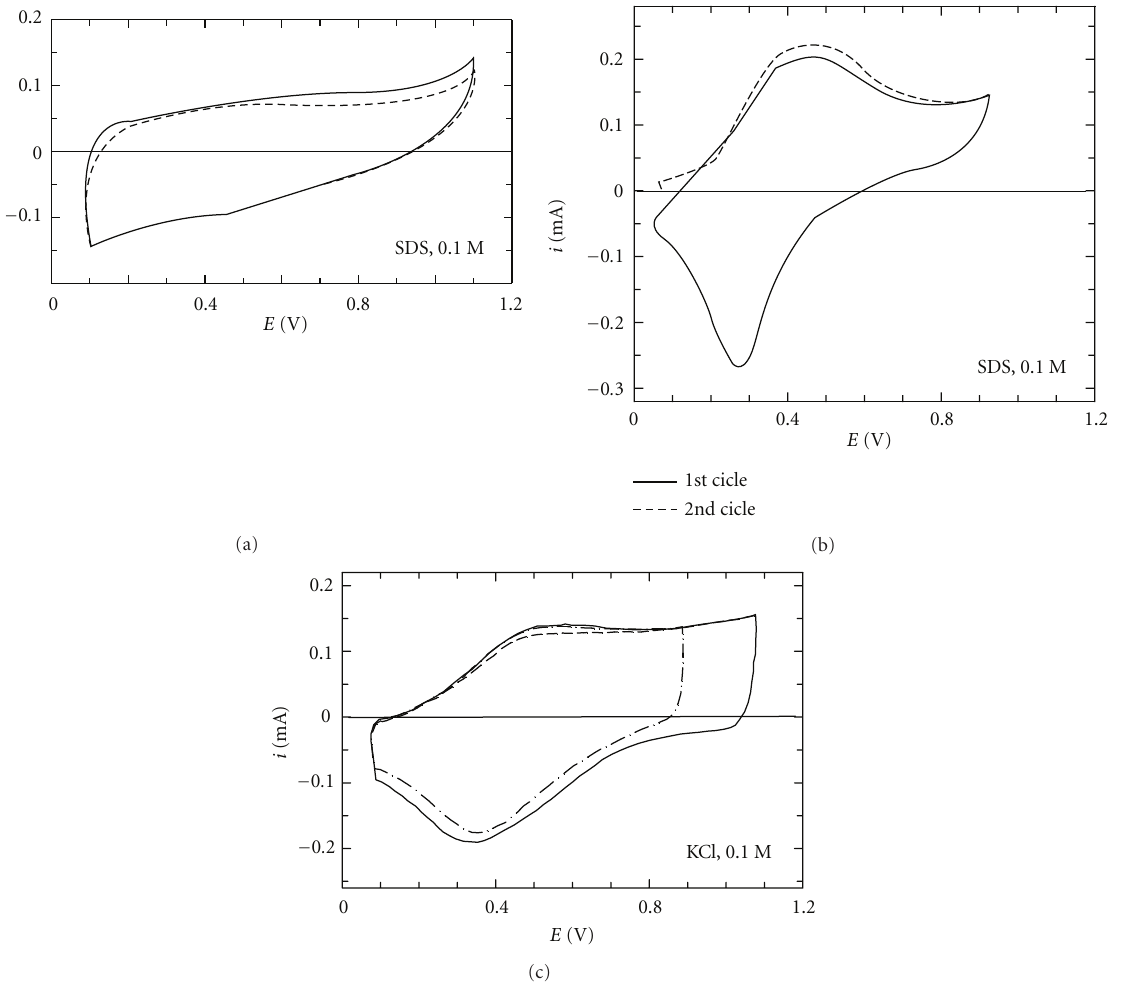
Figure 2: Current/potential voltammograms obtained scanning at 100 mV/s between Ec = 0.04 V and either Ea = 0.9V or Ea = 1.1 V. Pseudocapacitive response observed after five anodic cycles using (a) Ea = 1.2 V with τ = 20s, and (b) Ea = 1.4 V with τ = 15 s. (a) and (b) in SDS solution free of Py, (c) the same electrode shown in Figure 2(a) and after immersion in